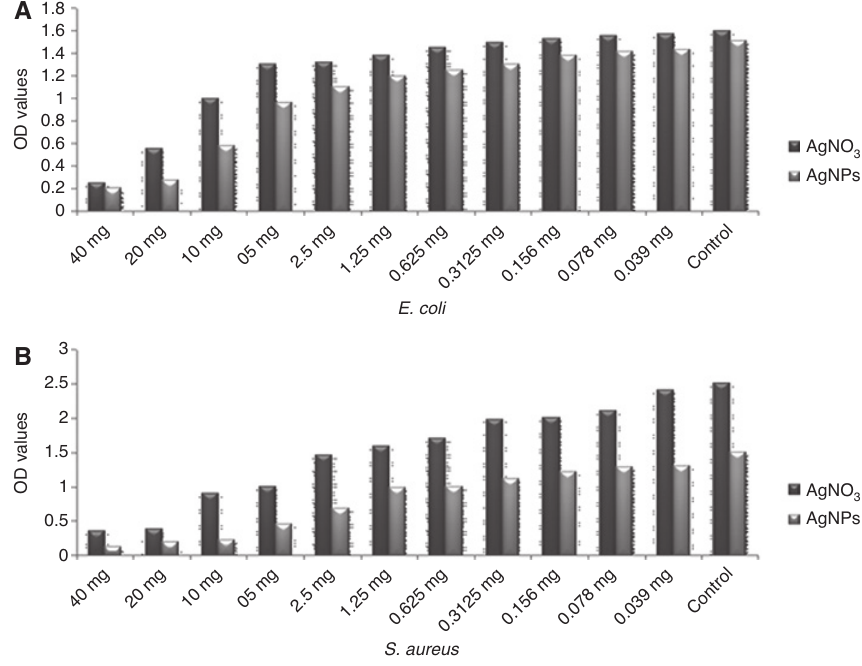
and AgNPs on (A) E. coli and (B) S. aureus . 3